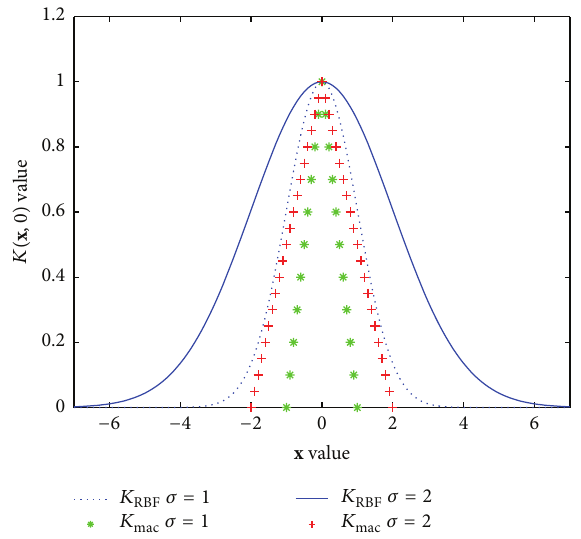
Mercer Theorem [18] . Assume that, for X ⊂ 𝑅 𝑛 , 𝐾( x , z ) is a continuous symmetric real value function on X × X such